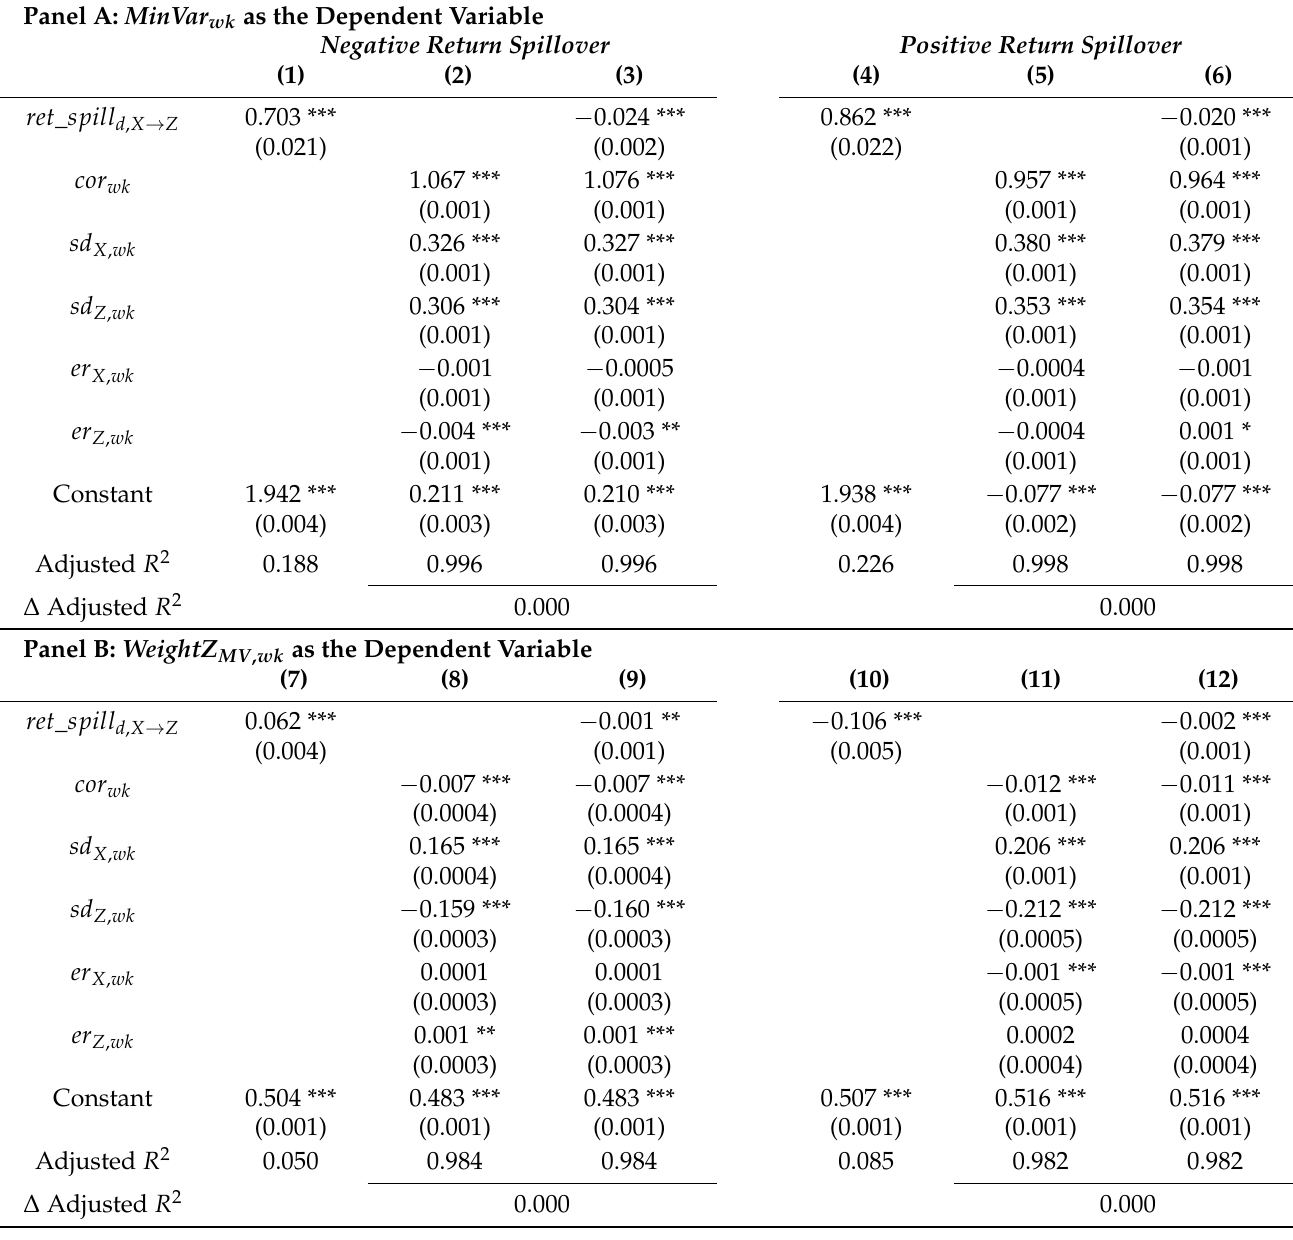
Table 3. Effects of return spillovers on optimal portfolios formed by lower frequency returns. This table presents the results from the regression of the weekly optimal portfolio characteristics on the daily return spillovers ( ret _ spill d , X → Z . Portfolio characteristics include the standard deviation of the minimum variance portfolio (Panel A), the Sharpe ratio of the maximum Sharpe ratio portfolio (Panel C), and corresponding weights of the spillover-receiving asset in such portfolios (Panels B and D). We use “daily” and “weekly” for the illustration purpose; the results also apply to other relative “high” and “low” frequencies. Control variables include weekly correlation ( cor wk ), weekly standard deviation and expected returns of the spillover-giving asset X ( sd X , wk and er X , wk ) and the spillover-receiving Z ( sd Z , wk and er Z , wk ). The last row in each Panel presents the difference between Adjusted R 2 of the full model and the restricted model without spillovers. Standard errors are in parentheses. *, **, and *** denote significance levels of 10%, 5%, and 1%,